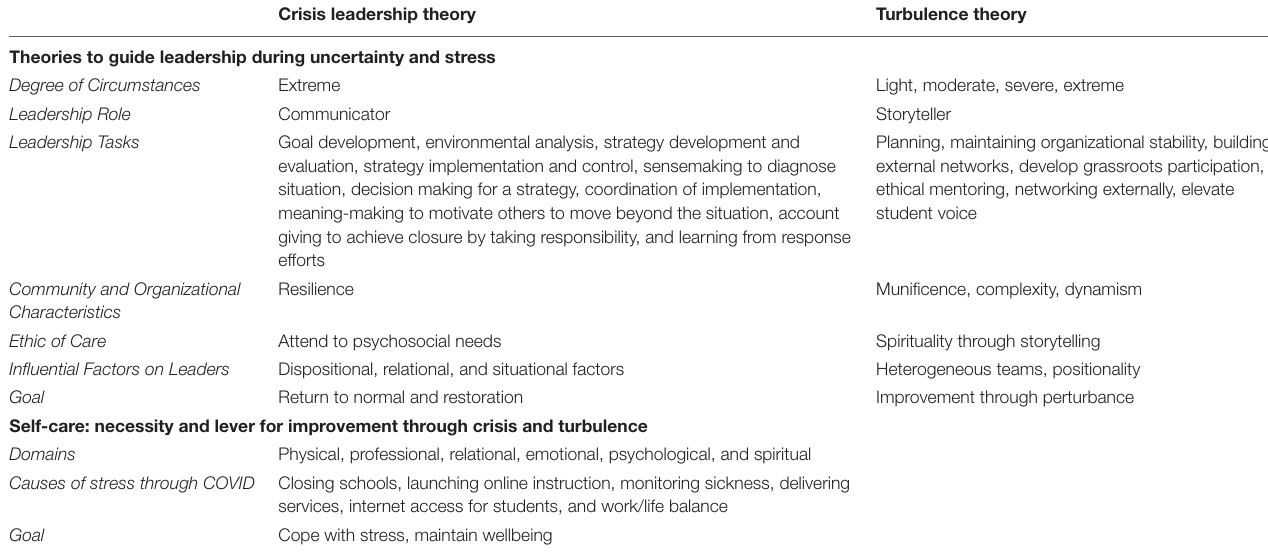
TABLE 3 | Overview of framing from crisis leadership, turbulence theory, and